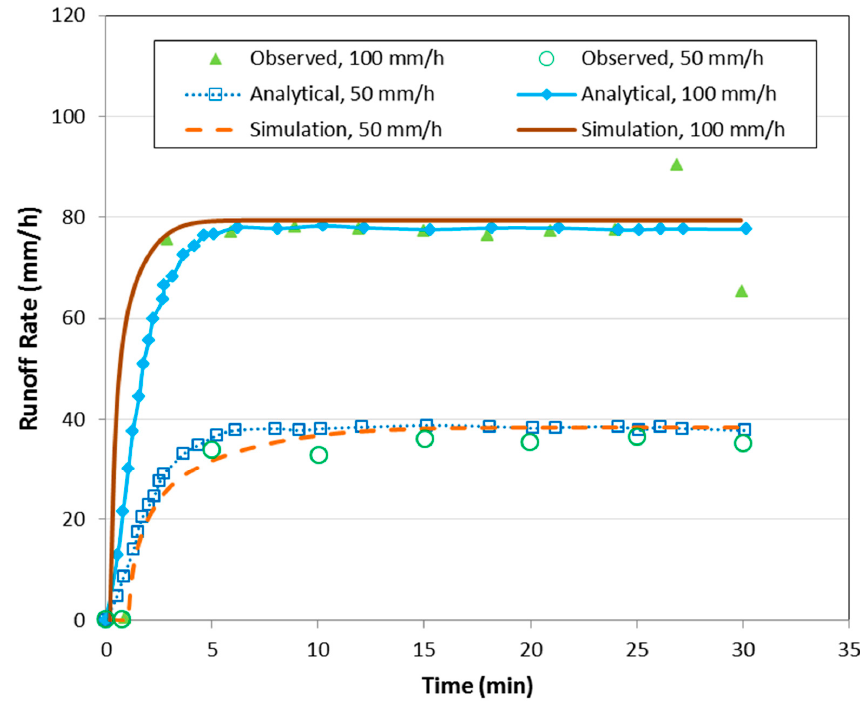
Figure 2. Model results: Calculated runoff rate and reference data (the analytical solutions were obtained from Govindaraju and Kavvas [25], while the observed experimental results were from Singer and Walker [24]).